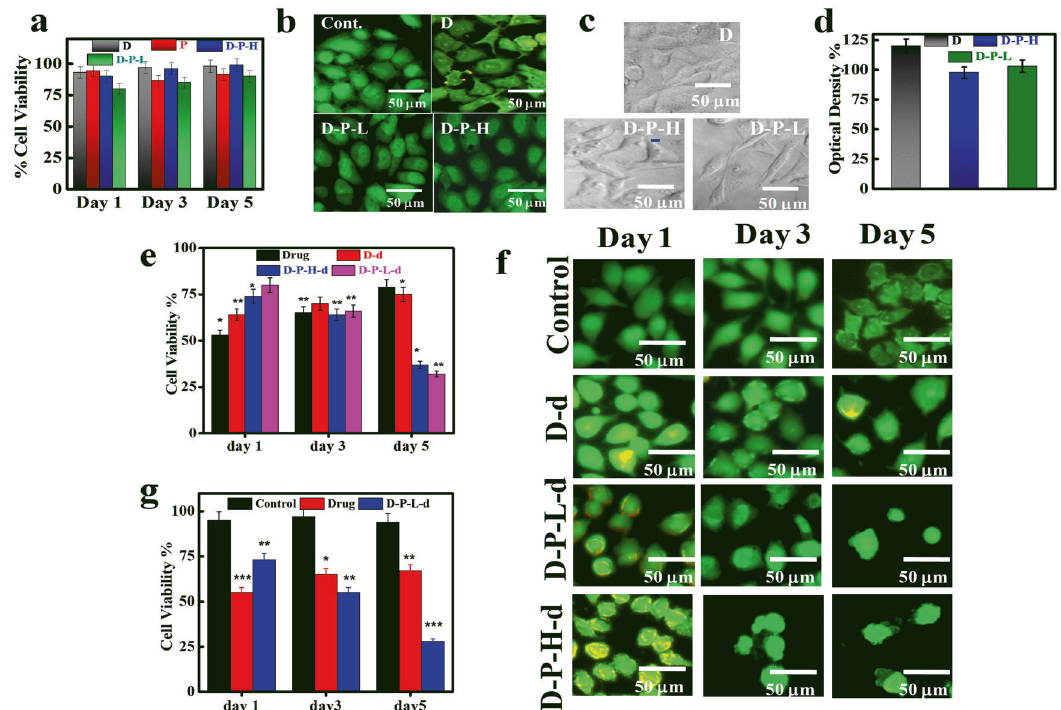
Fig. 4 Biocompatibility and in vitro cytotoxicity of brush copolymers and pure polymer. a Percentage cell viability obtained through MTT assay measurements of the indicated specimens. b Fluorescence images of cells treated with indicated systems after 24 h of incubation. c Phase-contrast images of HeLa cells grown on indicated polymeric fi lms, the images of cells adhered on the sample surfaces (cell adhesion). d Optical density of the adhered cell for an indication of cell viability. e In vitro cytotoxicity by using pure drug and drug-loaded brushes in HeLa cells at 250 μ g/ml of drug concentration at different time interval. f AO/EB stained fl uorescence images of cells after treatment with pure drug and drug-loaded brush copolymers: Results are presented in mean value ± SD, n = 5. *** p < 0.001, ** p < 0.01, and * p < 0.05. g In vitro cytotoxicity potential of pure drug and low graft density brush copolymer (D-P-L at 250 μ g/ml of drug concentration) in B16-F10 melanoma cells at different time interval (incubation